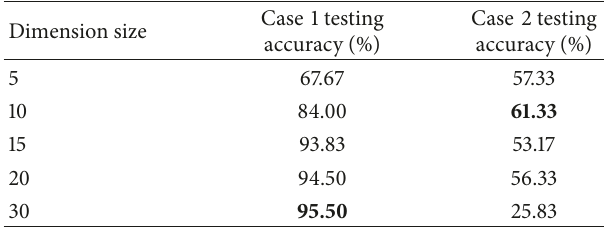
Table 16: Bearing fault diagnosis results obtained by the OFS-NPE-